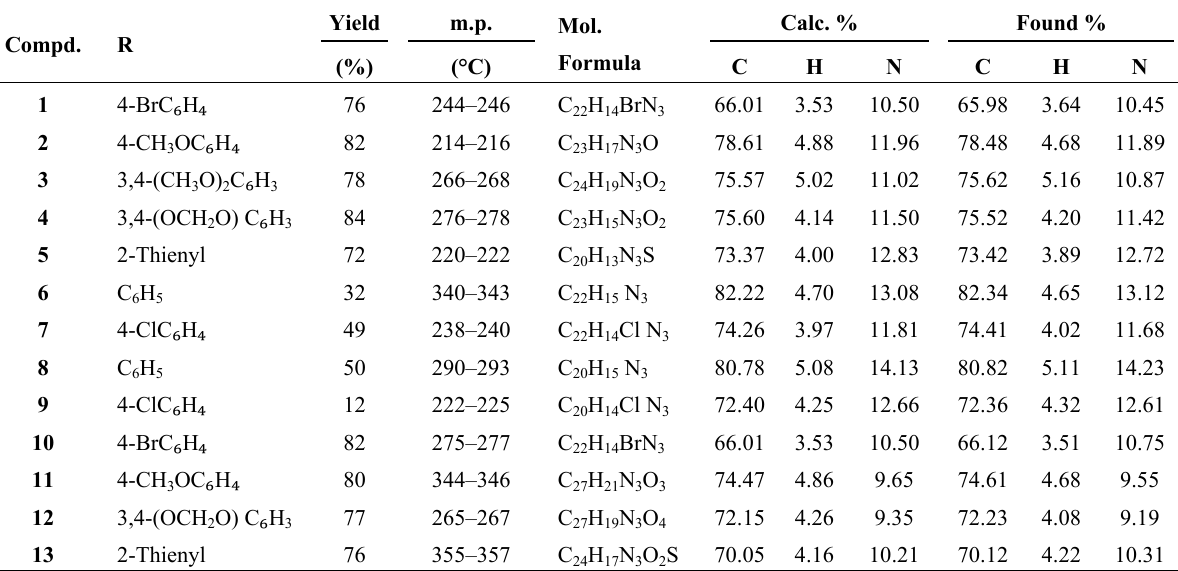
Table 1. Physical and analytical data of compounds 1 – 13 .